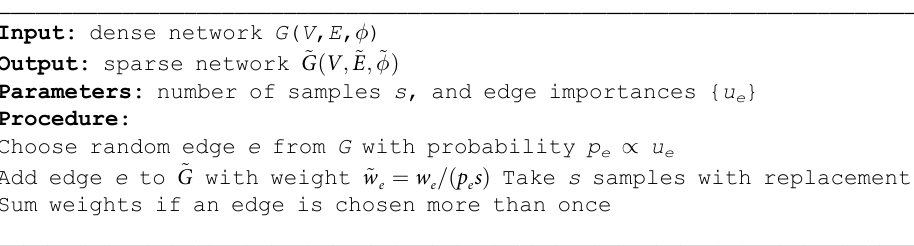
Algorithm 1: Edge-Sampling Sparsification